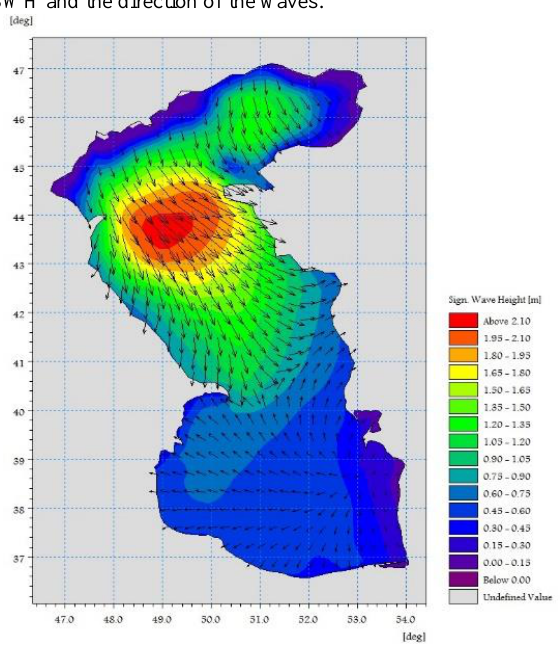
Figure 7. Schematic output for the Caspian Sea Using ECMWF wind data are reliable to use for wind wave numerical modeling. The model’s Mean R-squared is 0.8059 and the mean RMSE is 0.16155 meter which shows that the model is perfectly matched with measurement data and also it has better accuracy than the PMO simulation (Ports and Marin Organization of Iran,